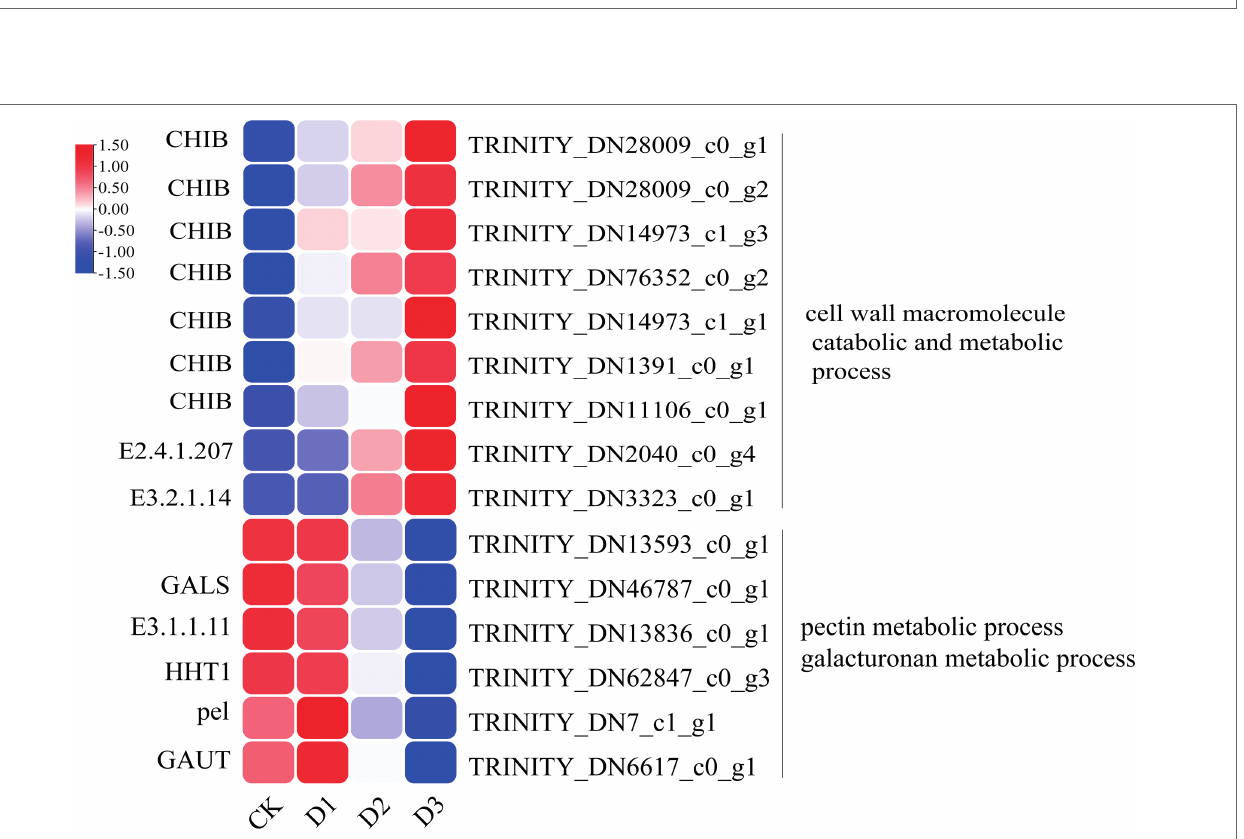
FIGURE 2 | The significant differentially expressed unigenes was significant enrichened ( p value corrected <0.05) of GO and KEGG pathways. (A) KEGG enrichment pathways; (B) GO enrichment items. The color was represented − log ( p value corrected), the red was showed the low p value corrected and the blue was high p value corrected. The up is up-regulated unigenes and the down is down-regulated unigenes. The figures were visualized by TBtools.